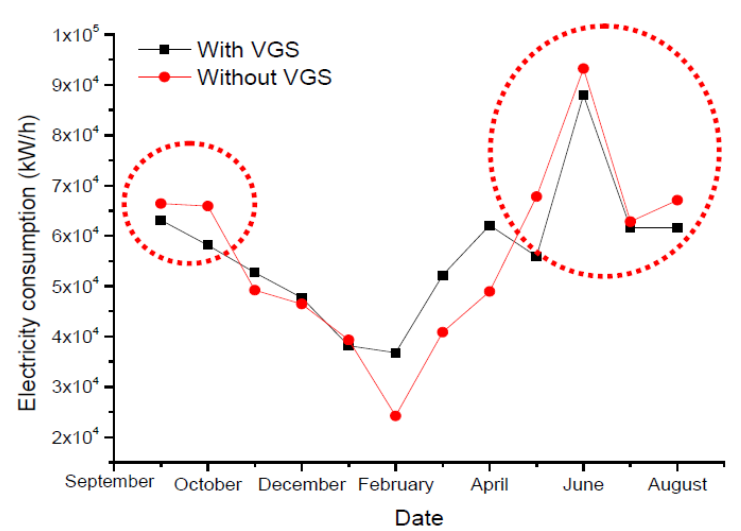
Figure 13. Annual electricity consumption.